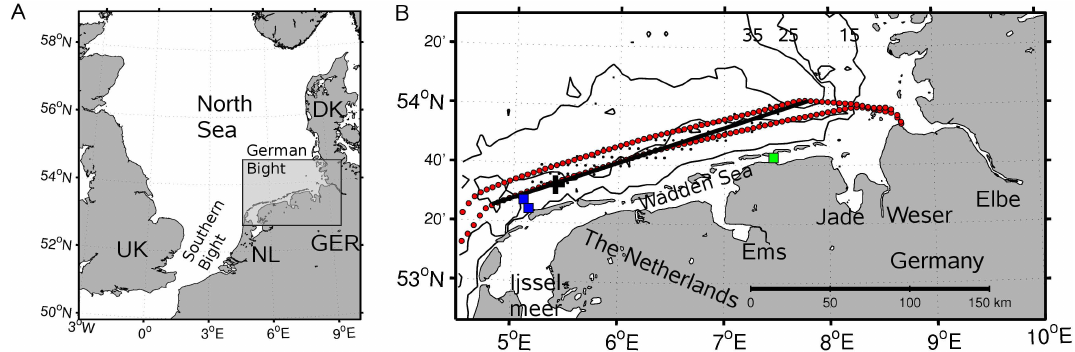
Fig. 1. (A) North Sea region including the study area (shaded). (B) Study area with the FerryBox route (red dots), the model transect (black line) and the release positions of the particles (black cross) at 5 . 4 ◦ E. Black dots indicate General Estuarine Transport Model (GETM) grid points used in the current analysis (see Fig. 3). Also shown are the coastal measurement pile (green square), nutrient measurement stations (blue squares) and depth contours (15, 25 and